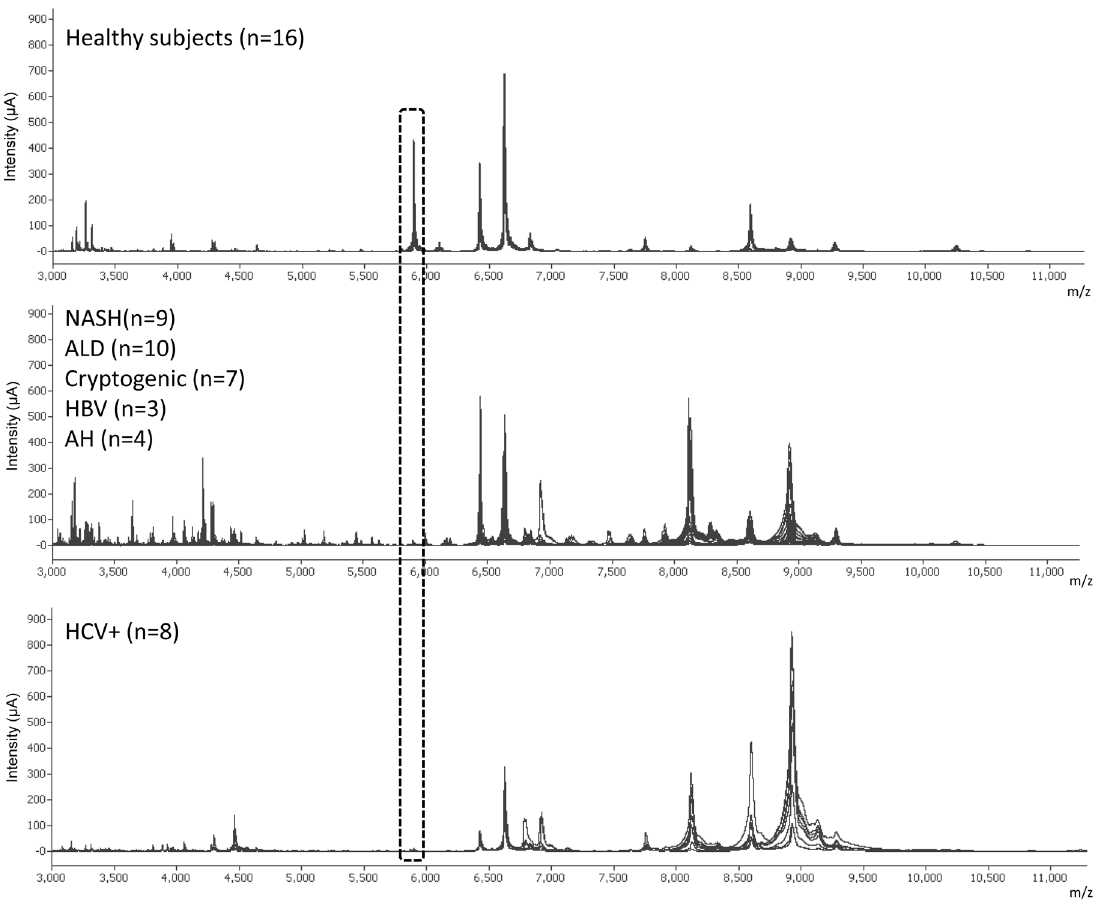
Figure 2. Lack of the 5.9 kDa protein peak in non-LT fibrotic patients. Portion of the SELDI-TOF-MS spectra comprised between 3000 and 11000 m/z of serum samples obtained from healthy subjects (n=16) and patients with liver fibrosis of several etiologies (NASH, ALD, cryptogenic, AH, HBV and HCV). The lack of the protein peak at m/z 5905 is clearly associated with fibrogenesis regardless of its etiology.